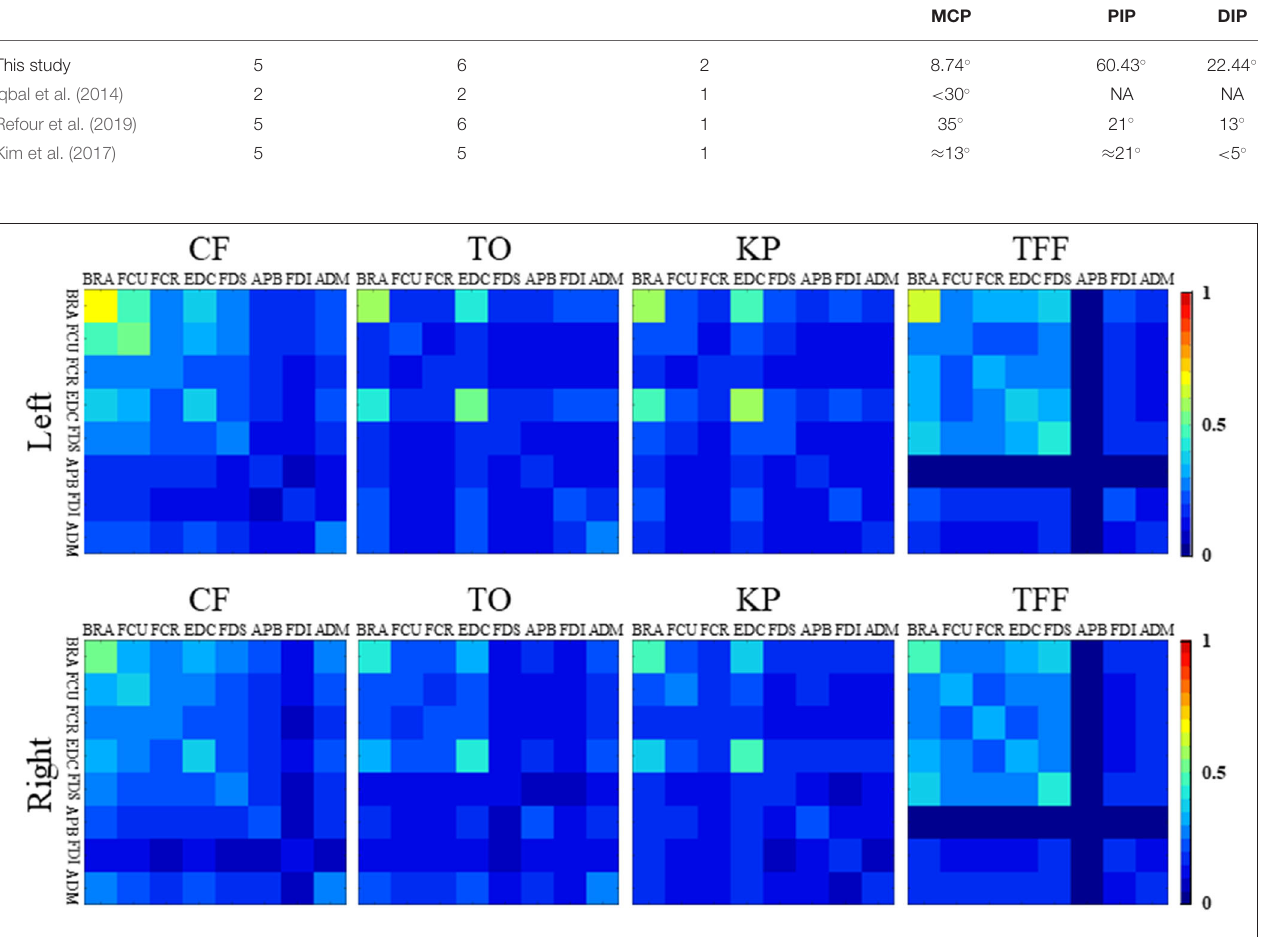
FIGURE 7 | The co-contraction index (CI) matrices for the four gestures of the left and right hands.